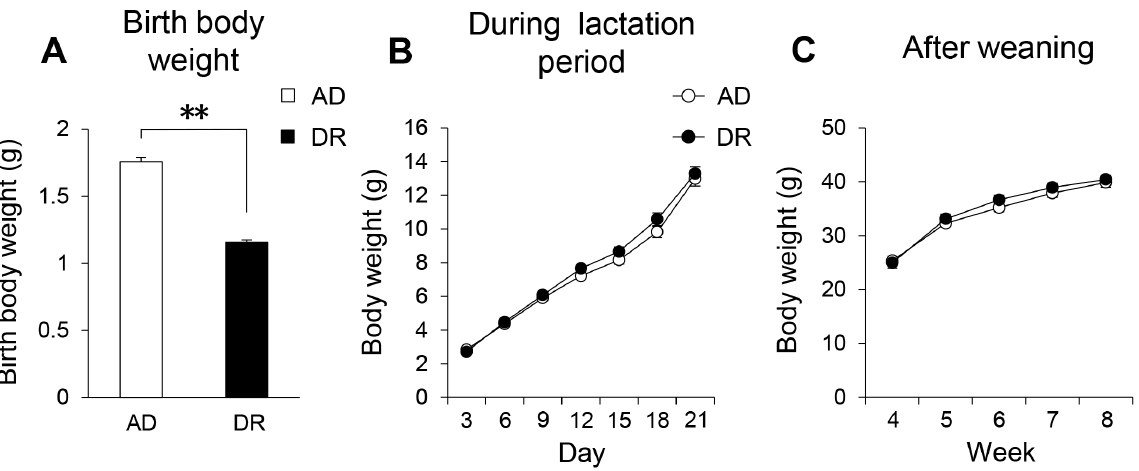
Figure 1. Birth body weight (A) and body weight changes during the lactation period (B) and after weaning (C) up to 8 weeks in offspring mice. Open bars and circles indicate AD mice. Closed bars and circles indicate DR mice. Data represent means 6 SEM (A; n=22–23, B; n=36–38, C; n=16). **p , 0.01 indicates a significant difference.